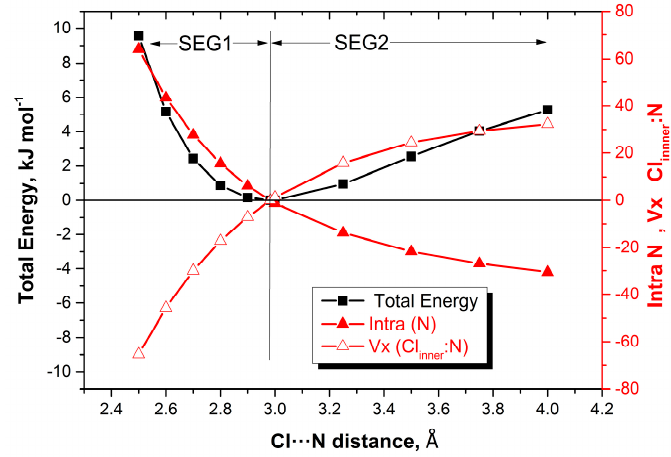
Figure 4. Energy profiles (total, intra-atomic energy of Cl inner , and interatomic exchange V x (Cl inner –N 3 )) of HCN:Cl 2 as a function of the distance between the “inner contact atoms” Cl inner and N 3 .